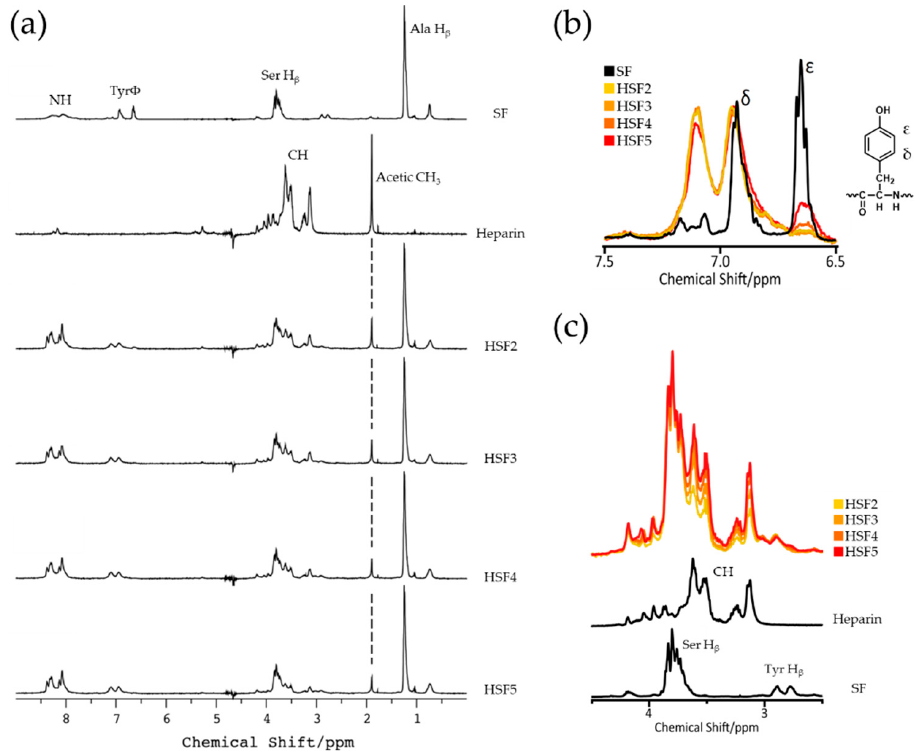
Figure 2. 1 H NMR spectra of SF and HSF aqueous solutions. Every concentration was 0.5 wt% and peak intensities were normalized by SF Ala H β . ( a ) SF, heparin, and heparin-modified SF samples (HSF2, HSF3, HSF4, and HSF5) from top to bottom. ( b ) Spectra around SF Tyr residues with a structural formula of a Tyr residue. ( c ) Spectra around a CH group region which contains heparin CH, SF Se) and Tyr residues demonstrated with different colors.